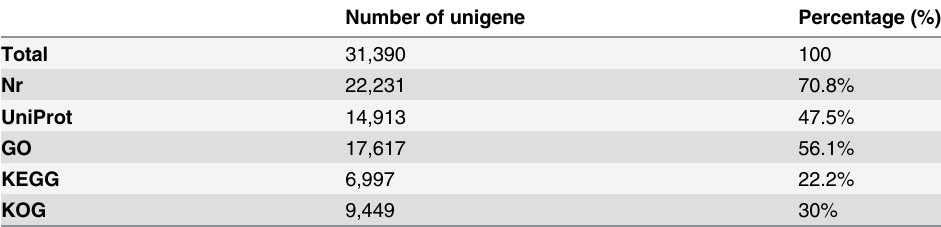
Table 1. Functional annotation of banana root transcriptome (all unigenes).